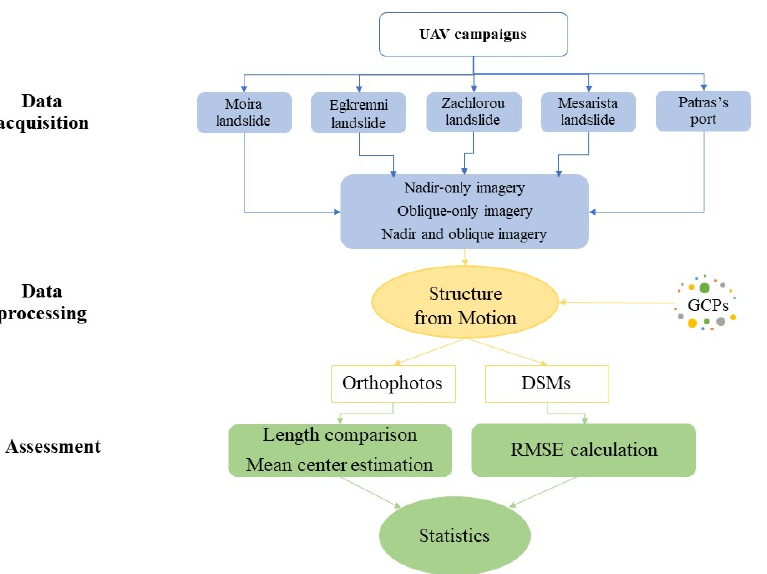
Figure 4. A flowchart showing the processing steps of the research methodology.